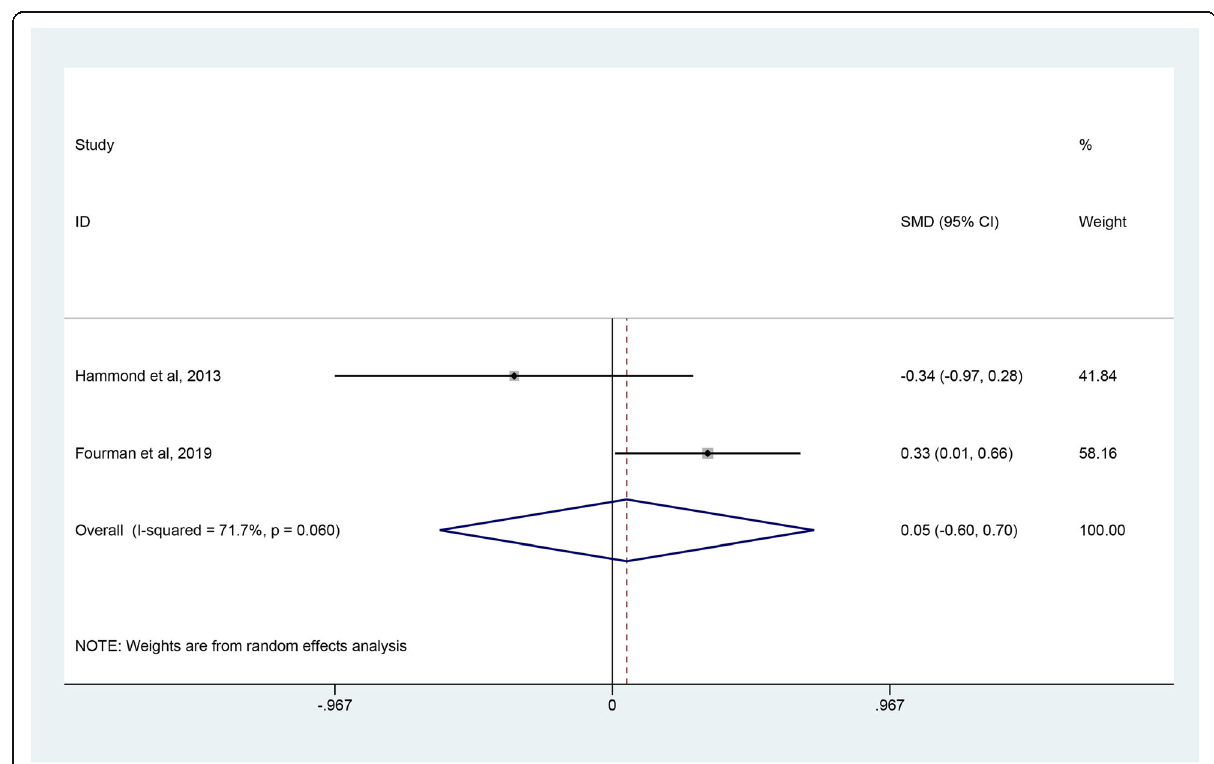
Fig. 4 Forest plot comparing ASES scores after resurfacing hemiarthroplasty (RHA) versus stemmed hemiarthroplasty